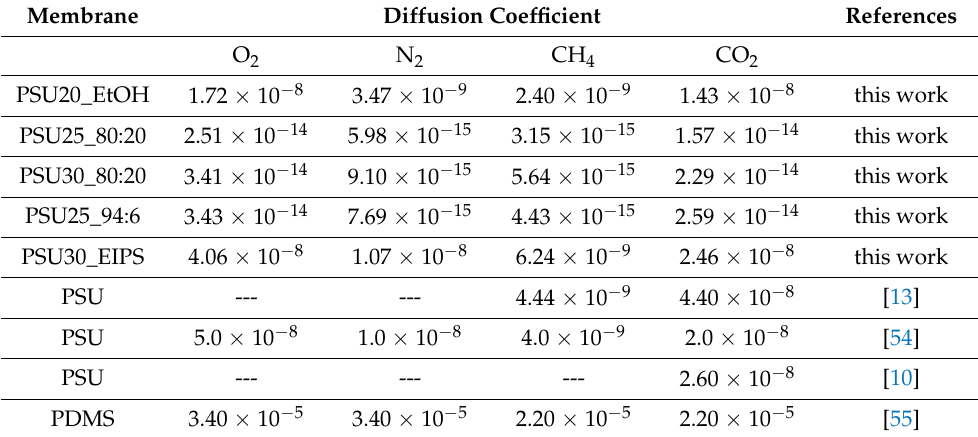
Table 5. Diffusion coefficients of the gases O 2 , N 2 , CH 4 and CO 2 in PSU and PDMS flat sheet